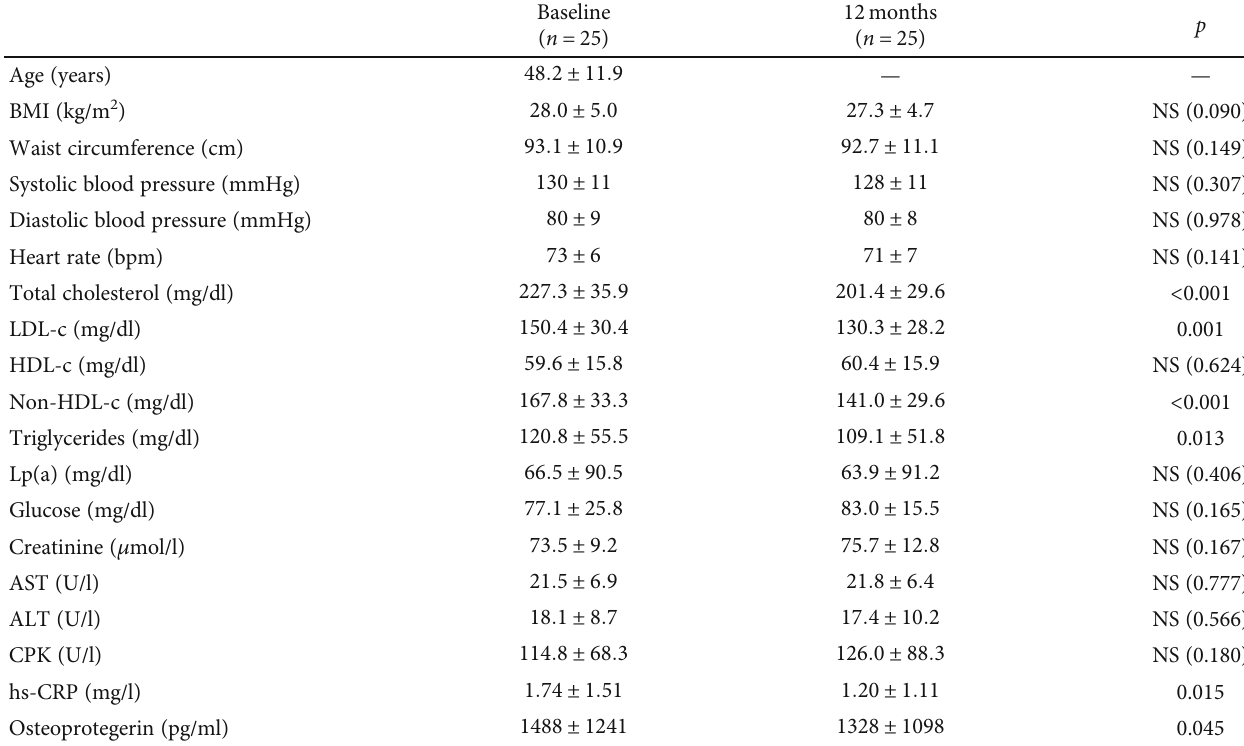
Table 1: Anthropometric and biochemical data at baseline and follow-up.